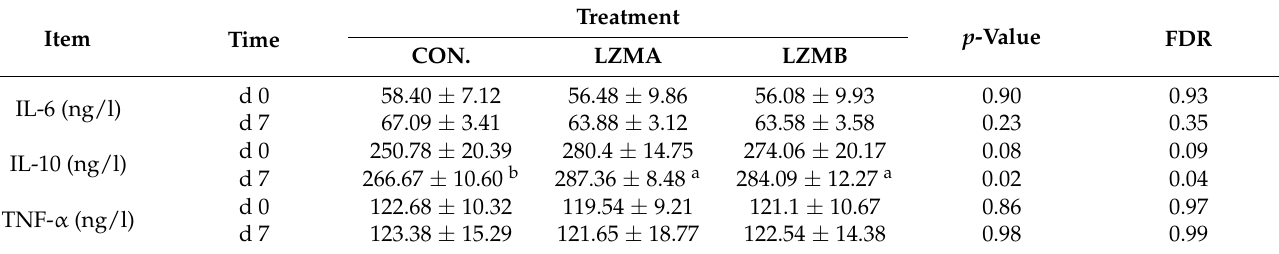
Table 1. Effect of lysozyme on serum cytokines of sow.